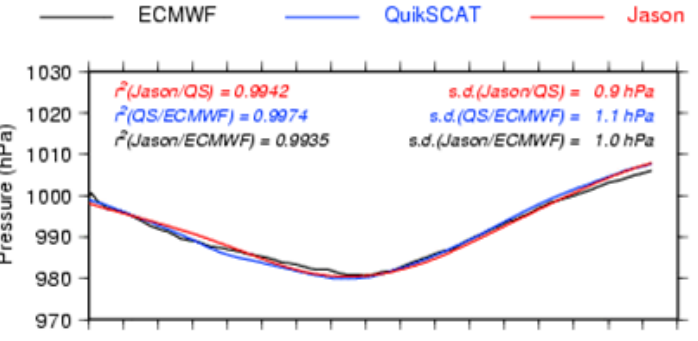
Figure 12. Comparison of the along-track SLP for the ETD of 23/04/2004 21:08 UTC QuikSCAT time. The abscissa shows the along-track distance in km (one stick every 100 km).